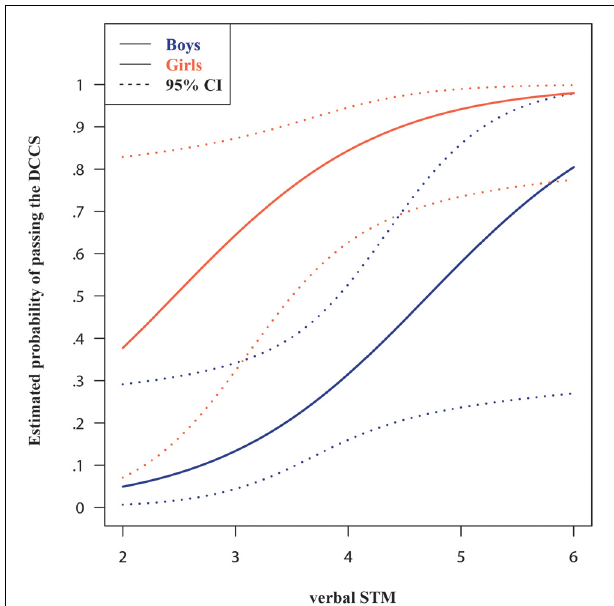
FIGURE 5 | Estimated probabilities of success on the shifting (DCCS) task, as a function of verbal STM span and gender. Estimated means correspond to boys and all other (non-significant) continuous model predictors were set to the mean sample values. STM, short-term